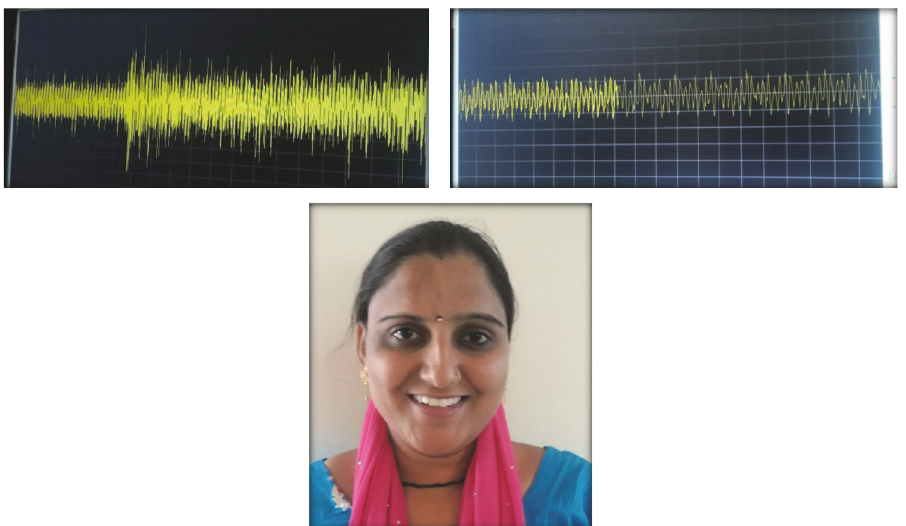
Figure 4: Follow-up visits at six-month period revealed complete absence of the dystonic contractions.